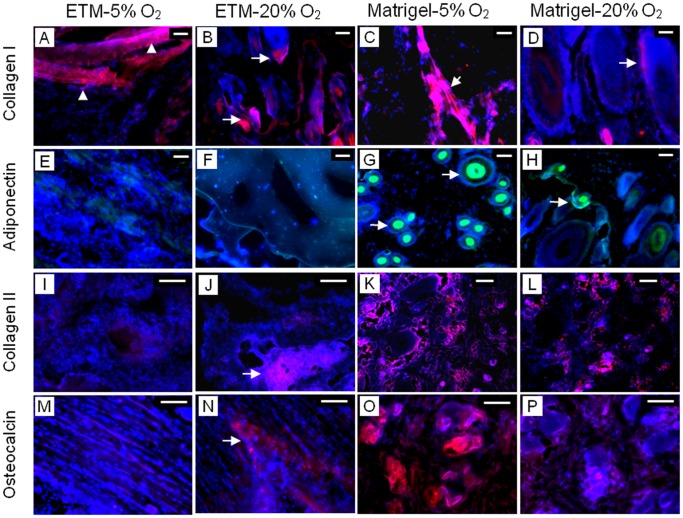
In vivo implantation results of hTSCs after culture in hypoxic and normaxic conditions.hTSCs grown under both hypoxic or normaxic conditions were implanted into nude rats. Implantation of the cells embedded in ETM (ETM-5% O2) resulted in the formation of tendon-like structures (A, triangles) compared to only spotty areas stained with human collagen type I (B, arrows) when hTSCs treated with 20% O2 and embedded in the same ETM (ETM-20% O2) were implanted in vivo. In addition, implantation of ETM-5% O2 hTSCs led to little formation of adiponectin (E), collagen type II (I), and osteocalcin (M); in contrast, implantation of ETM-20% O2 hTSCs exhibited strong staining for collagen type II (J, arrow) and osteocalcin (N, arrow). When hTSCs were treated with 5% O2 and embedded in Matrigel, implantation of the cell-Matrigel composites formed more extensive tendinous (C, D, arrows) and non-tendinous tissues (G, green; K, red; O, red) compared to hTSCs treated with 20% O2 and embedded in Matrigel (H, green; L, red; P, red). Red represents collagen type I (A–D); Green represents adiponectin (E–H); Red represents collagen type II (I–L) and red represents osteocalcin (M–P). In all figures blue represents nuclei stained with Hoechst 33342. Scale bars: 100 µm.G.